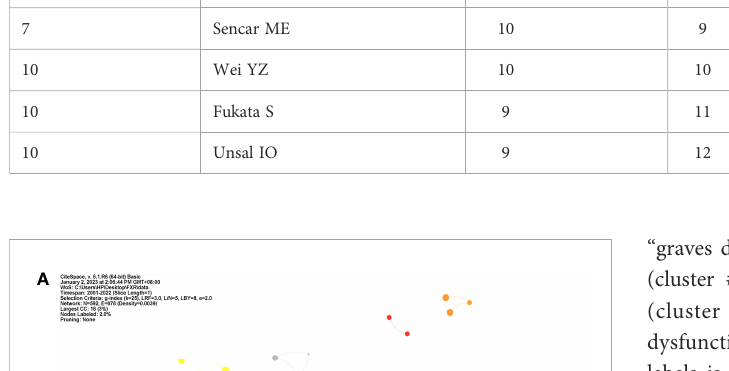
(cluster #7), “ subacute thyroiditis ” (cluster #8), and “ liver dysfunction ” (cluster #9) (Figure 7B). The amount of cluster labels is inverse to the number of articles each cluster contains.